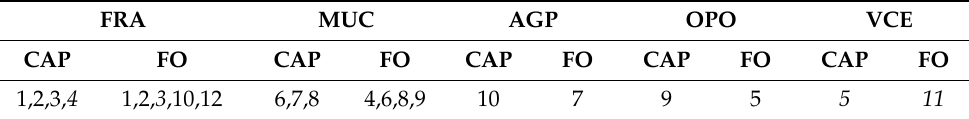
Table 13. Placement of pilots at the time of the occurrence of an emergency. FRA